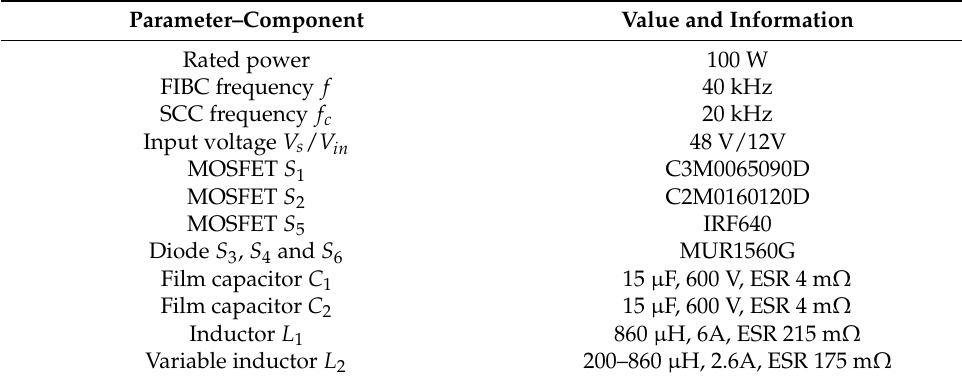
Figure 10. Experimental prototype. Table 1. Specifications of the